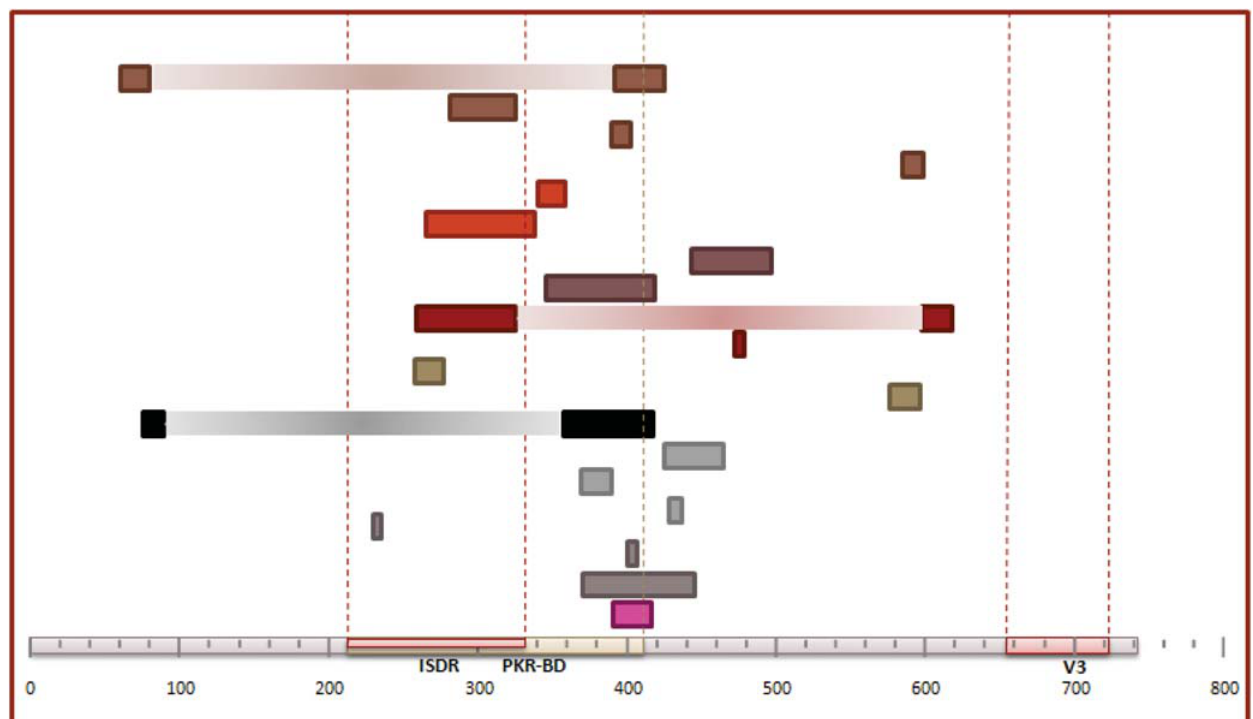
Figure 8. Location of recombination breakpoints detected in the NS5a region.